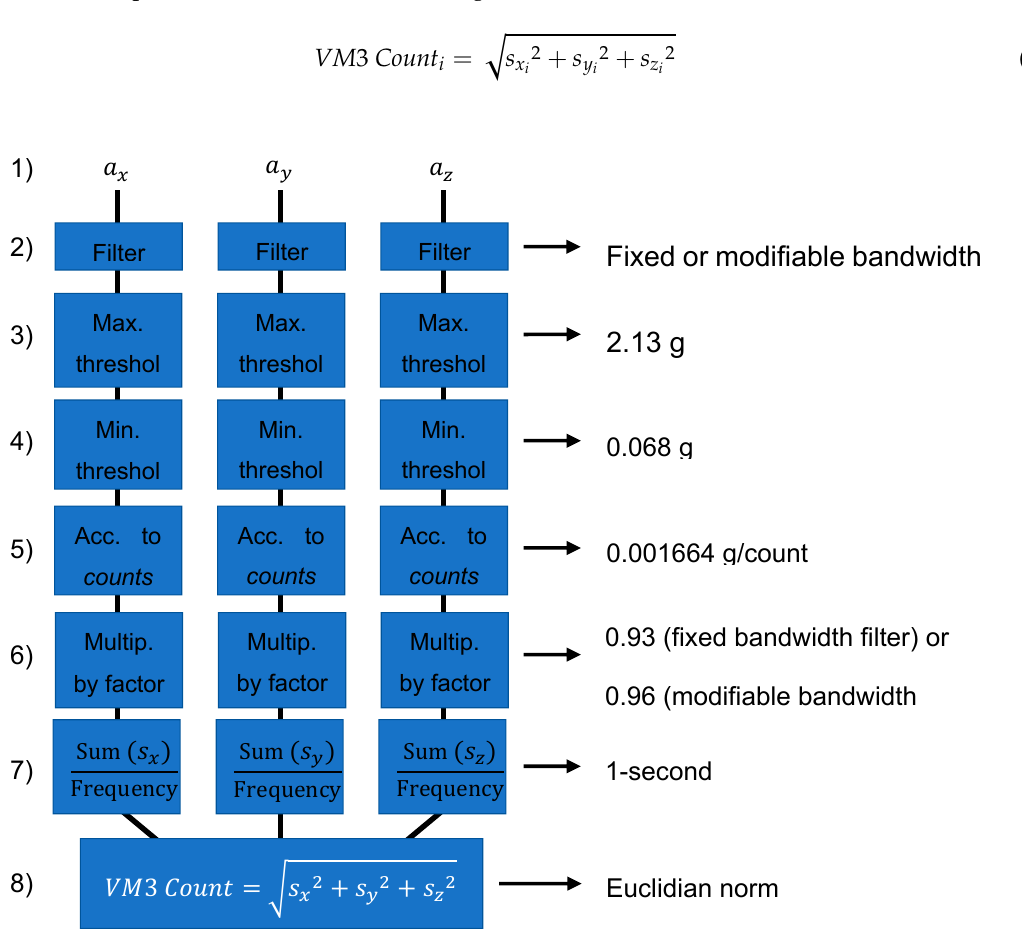
Figure 1. Activity quantification algorithm scheme.